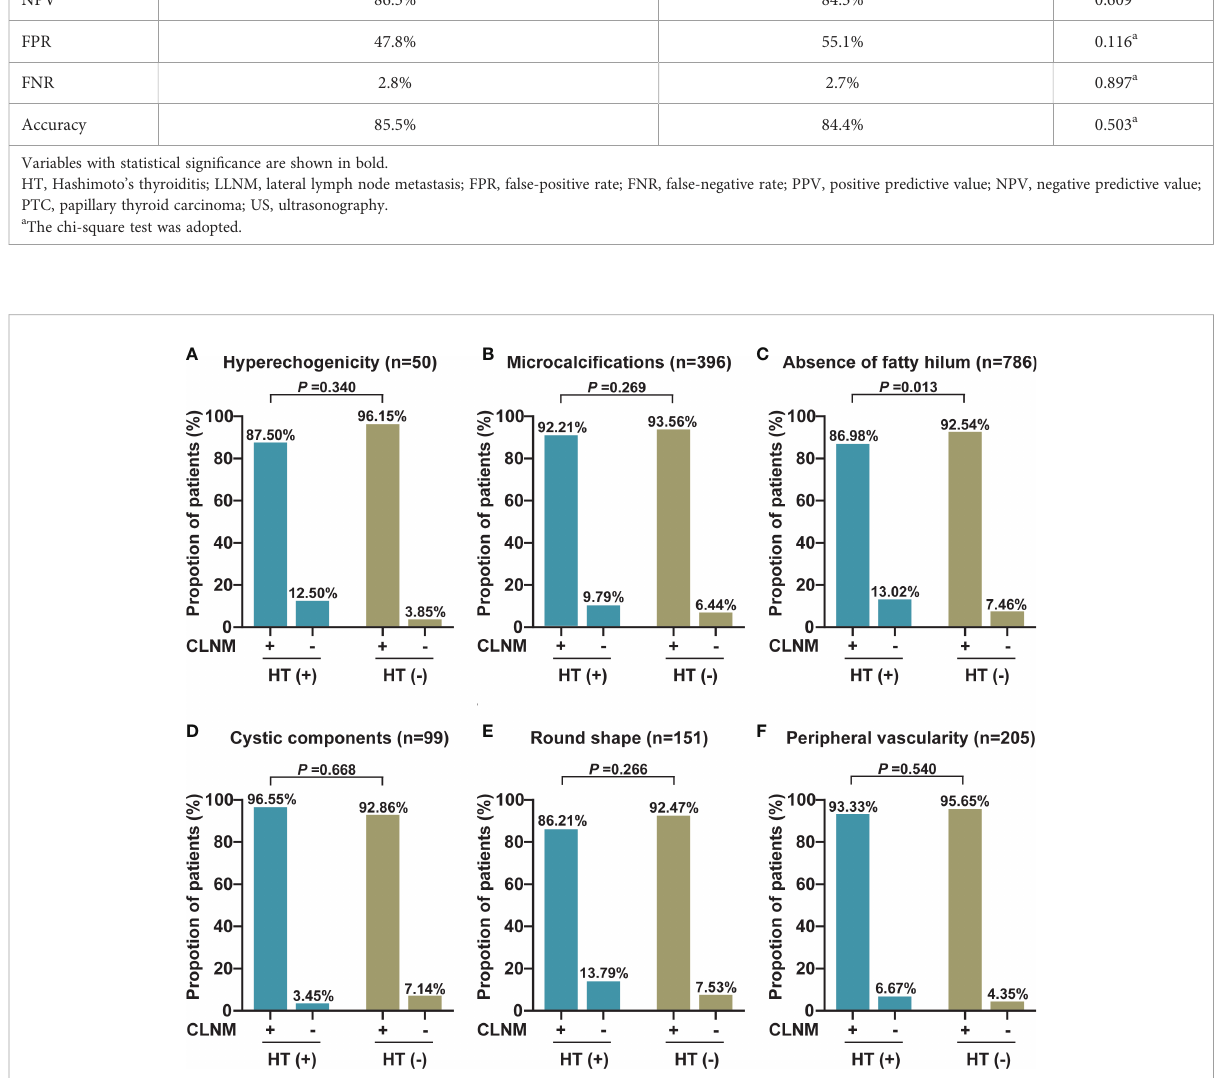
FIGURE 2 The proportion of each abnormal US feature between malignant and benign central LNs in PTC patients with or without HT. (A) The proportion of hyperechogenicity ( n = 50). (B) The proportion of microcalci fi cations ( n = 396). (C) The proportion of the absence of fatty hilum ( n = 786). (D) The proportion of cystic components ( n = 99). (E) The proportion of round shape ( n = 151). (F) The proportion of peripheral vascularity ( n = 205). CLNM, central lymph node metastasis; HT, Hashimoto ’ s